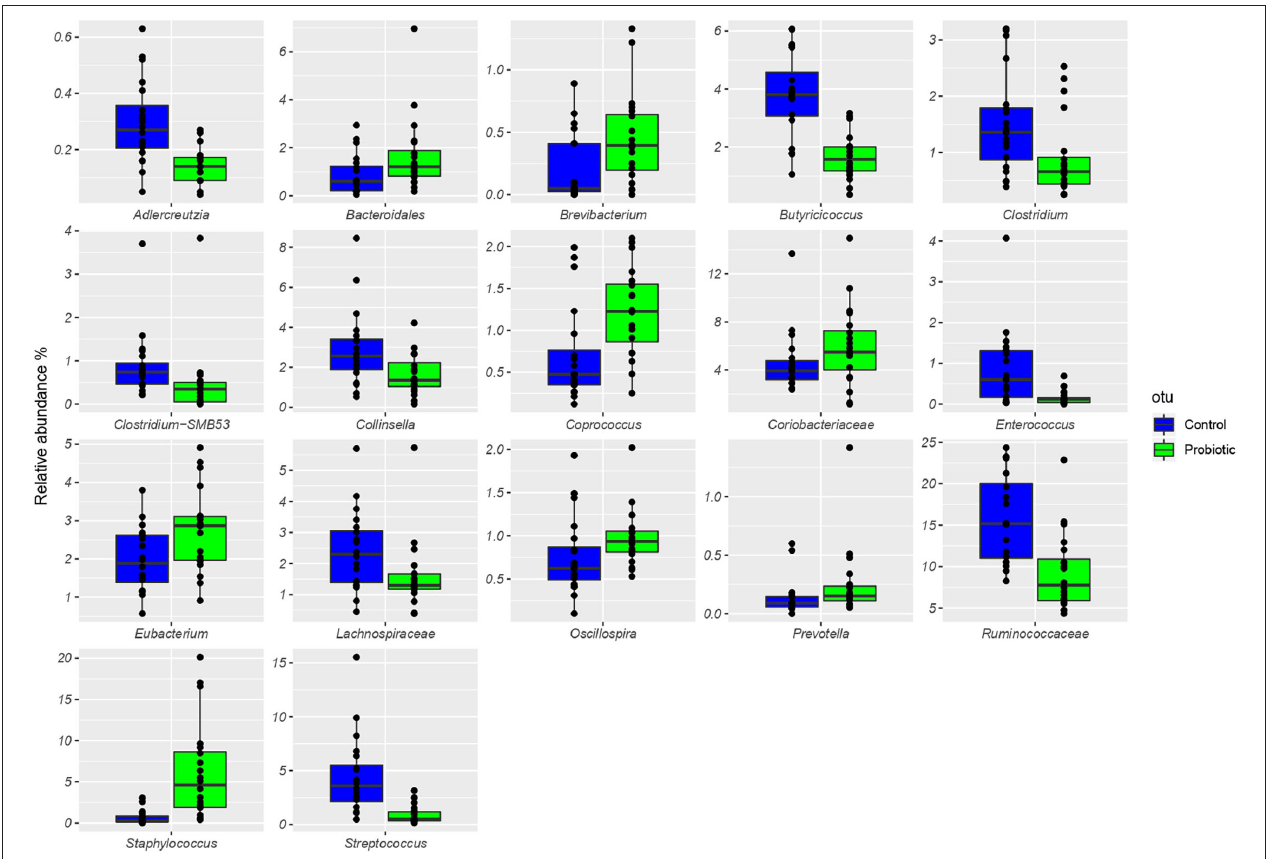
FIGURE 3 | Boxplots showing the relative abundance at genus or family level of the OTUs differentially abundant based on Wilcoxon matched pairs test ( p < 0.05) in cecal samples of the treated group (P), receiving water plus a commercial multi-strain probiotic Slab51 ® (blue bars), and the control group C (green bars).